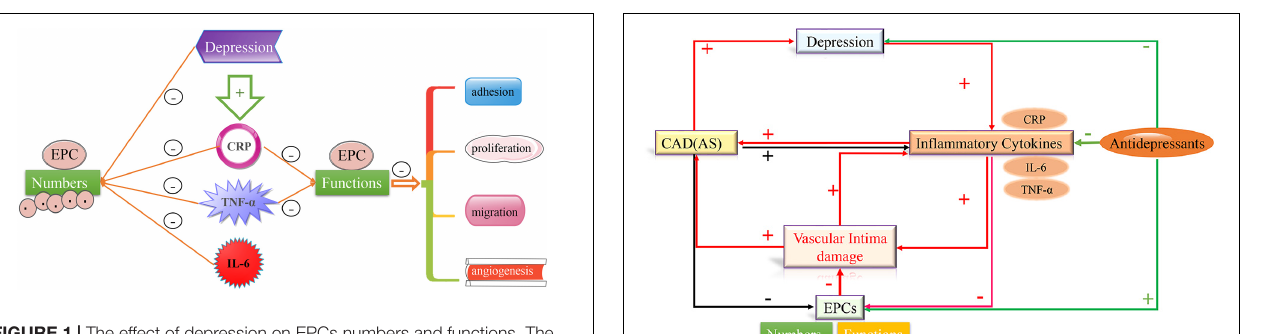
FIGURE 1 | The effect of depression on EPCs numbers and functions. The level of TNF- α , CRP, and IL-6 in peripheral blood of patients with depression are higher than that of healthy subjects, and the level of TNF- α , CRP, and IL-6 have a negative correlation with EPCs numbers. TNF- α and CRP can inhibit the functions of EPCs, such as adhesion, proliferation, migration and angiogenesis in vitro study. Whether depression can affect the above functions of EPCs through TNF- α or other inflammatory factors will require further studies.